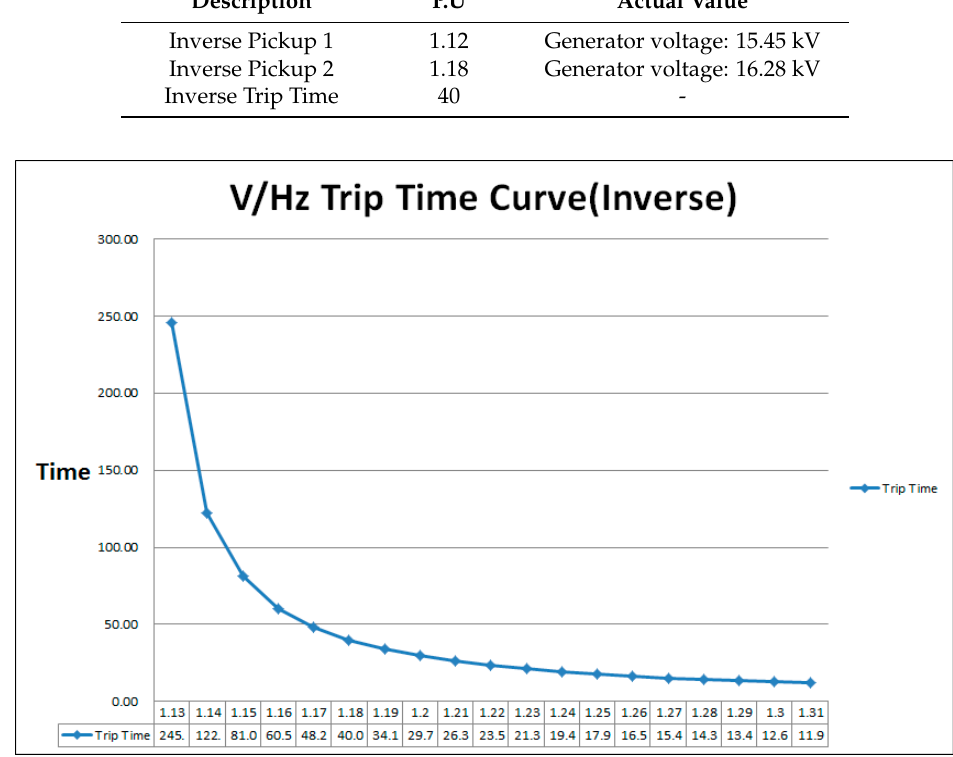
Figure 20. V/Hz trip time curve.